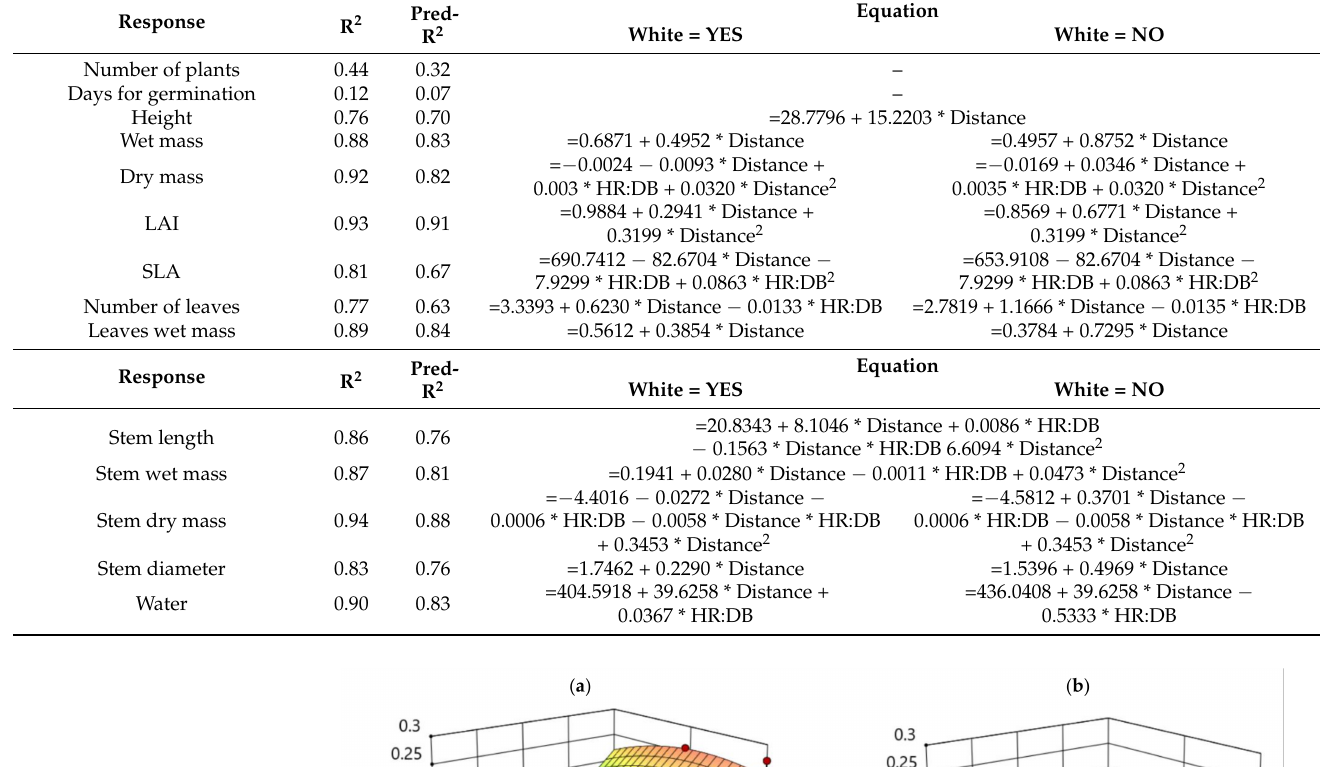
Table 9. ANOVA results.